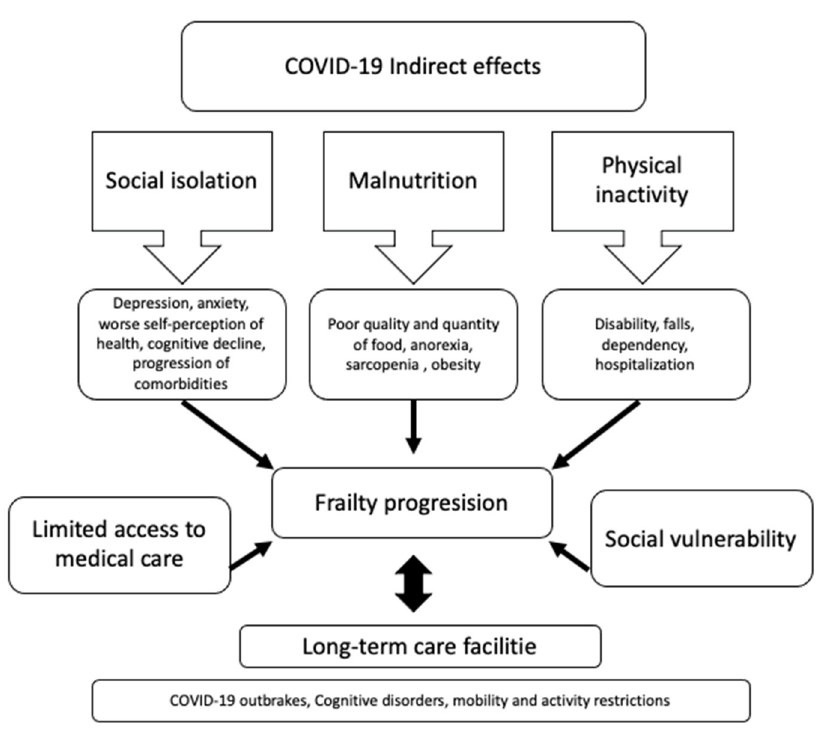
Figure 3. Indirect effects associated with COVID-19 infection leading to progression of frailty.